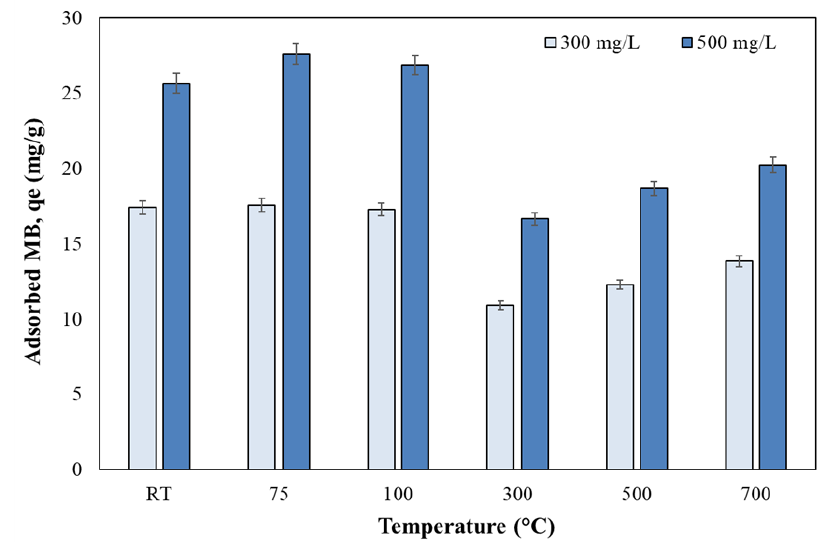
Figure 1. Impact of thermal treatment on methylene blue (MB) adsorption capacity onto rice husk.